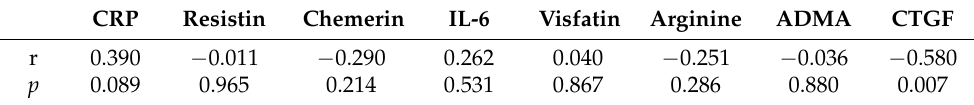
Figure 3. Association of A β 42 serum levels with diabetes, ascites, and varices. ( A ) SVS A β 42 serum levels in 8 patients with and 12 patients without diabetes. ( B ) Correlation of SVS A β 42 with serum CTGF. ( C ) SVS A β 42 serum levels in eight patients with no/little and 12 patients with moderate/massive ascites. ( D ) SVS A β 42 serum levels in seven patients with no/small and 13 patients with large varices. Table 3. Spearman correlation coefficients (r) and p -values ( p ) for the association of systemic A β 42 with inflammatory markers, proteins with a role in nitric oxide production, and connective tissue growth factor